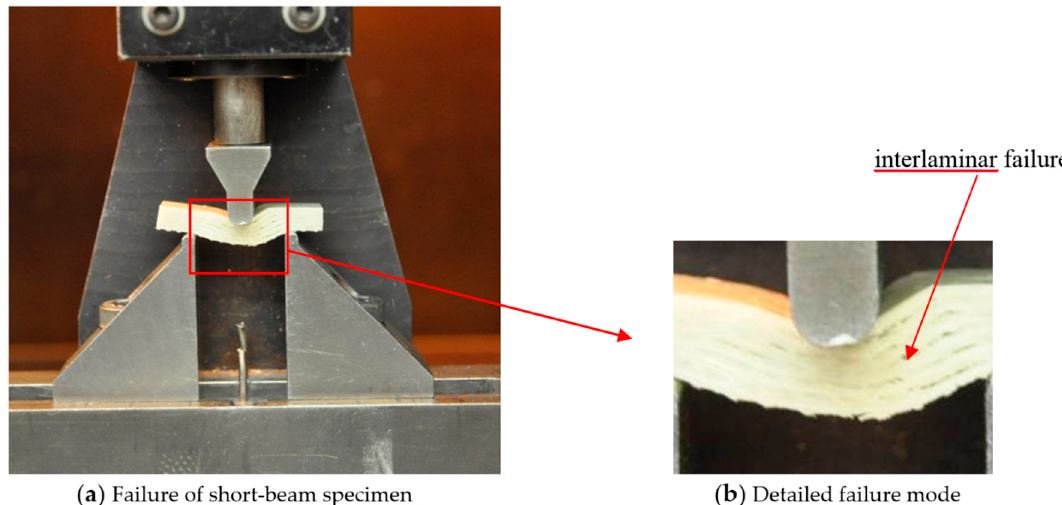
Figure 6. Failure mode of the short-beam shear test specimen.